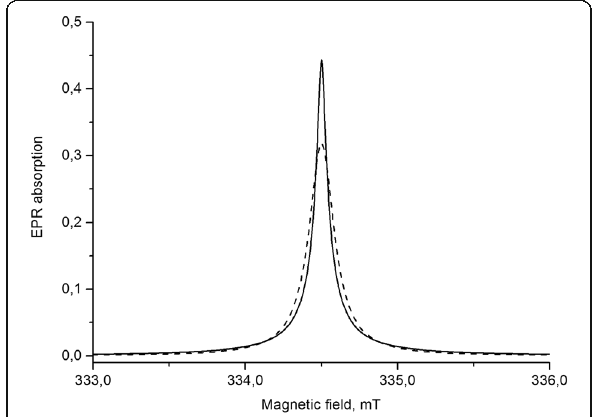
Fig. 7 Comparison of absorption signals of the Lorentz shape ( dotted line ) with the line shape for the 2D system ( solid line ) with unit amplitudes and widths of